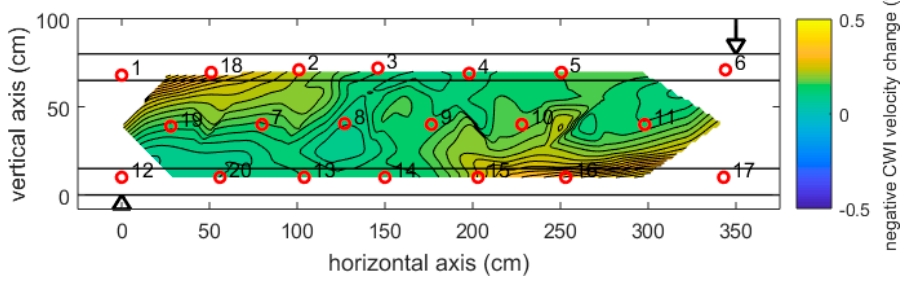
Figure 12. Girder DLT 1.3: Velocity change at 250 kN load, revealed by step-wise CWI and interpolations between positions of transmitter receiver pairs. Arrow: Loading point. Triangle: central support.